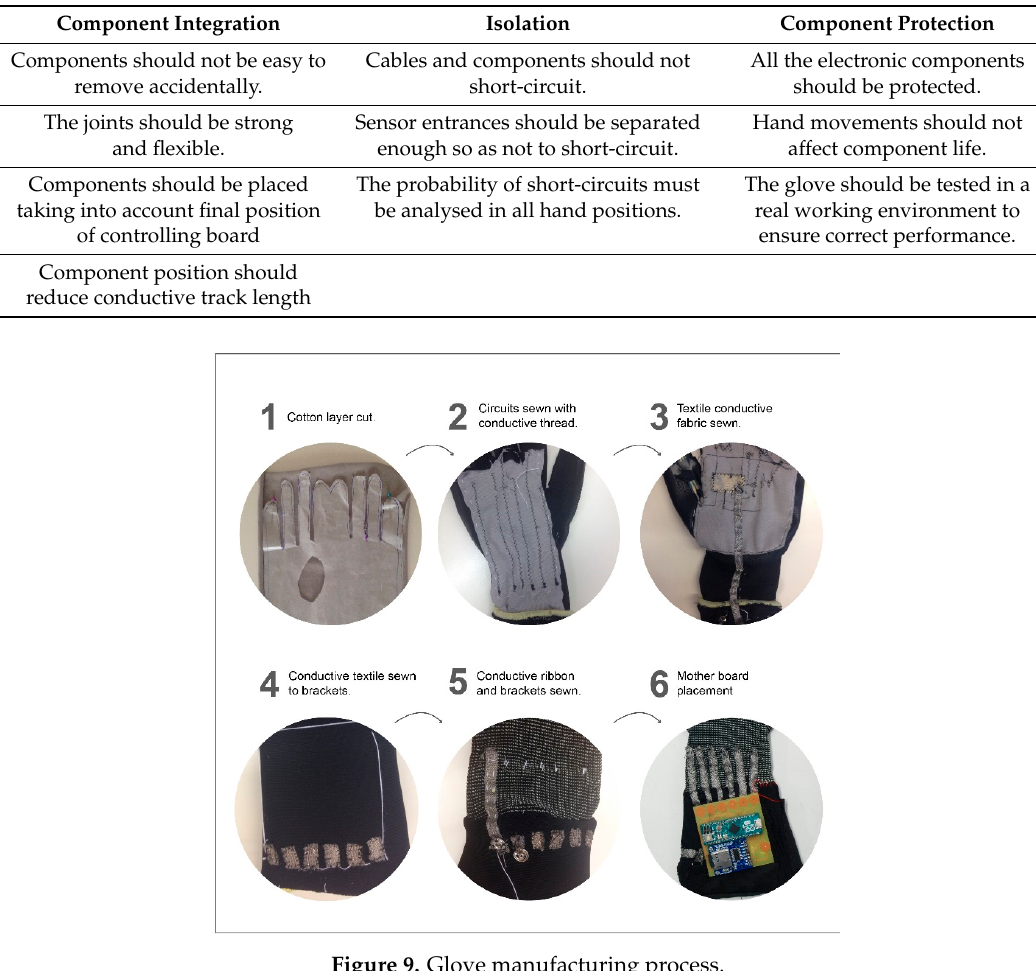
Figure 9. Glove manufacturing process. Sensors 2018 , 18 , x FOR PEER REVIEW